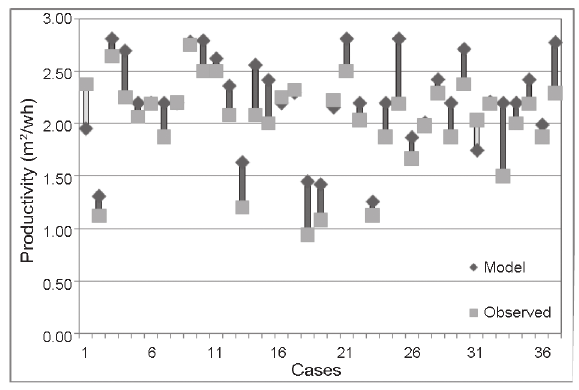
Fig. 3. The observed and estimated crew productivity for FF1